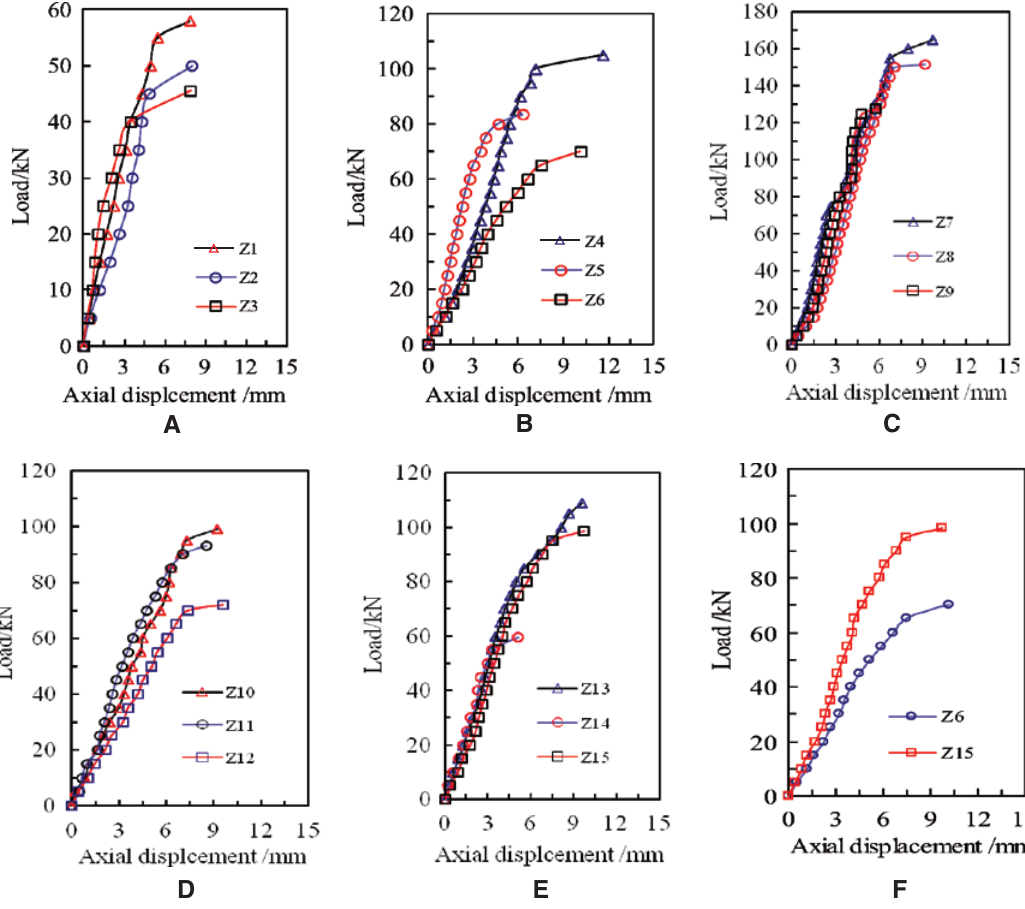
Figure 14: N-u curves for different slenderness